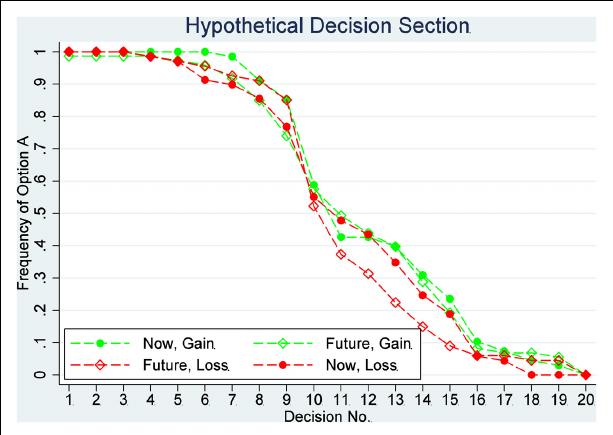
FIGURE 3 | Average switch point by treatment: the hypothetical decision